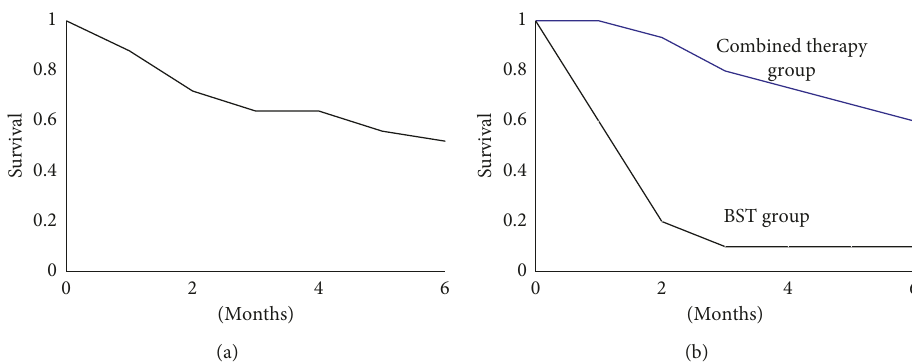
Figure 4: Kaplan–Meier analysis of patients in two groups for 6months. (a) The overall survival of all patients. (b) The overall survival of BST (best support therapy) group or combined therapy